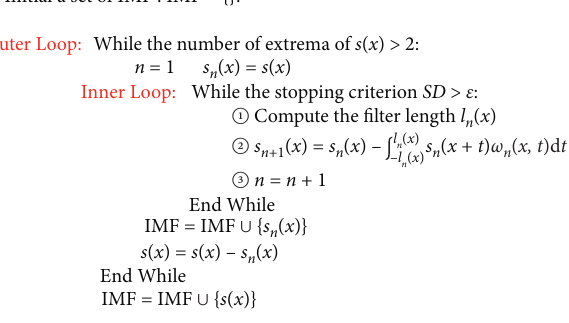
Figure 3: The algorithm of